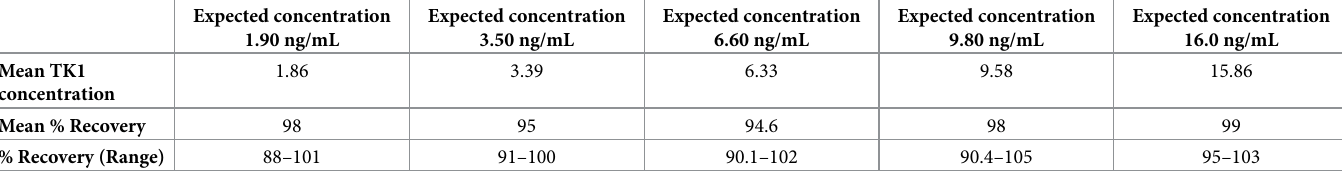
Table 4. The % recovery of TK1 protein after spiking blood donor sera with human recombinant TK1. Expected concentration 1.90 ng/mL